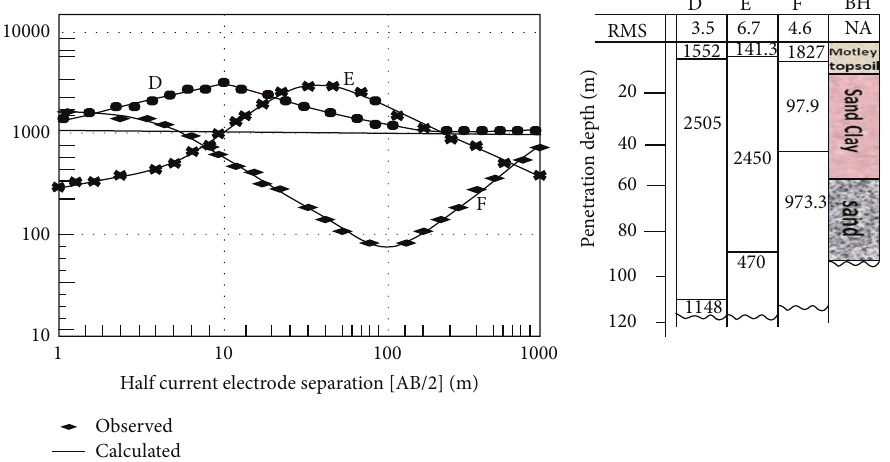
Figure 3: Typical VES curves and modelled results obtained along B-B 1 profile (D FRS Office, E Ik. Club and F FCMB).